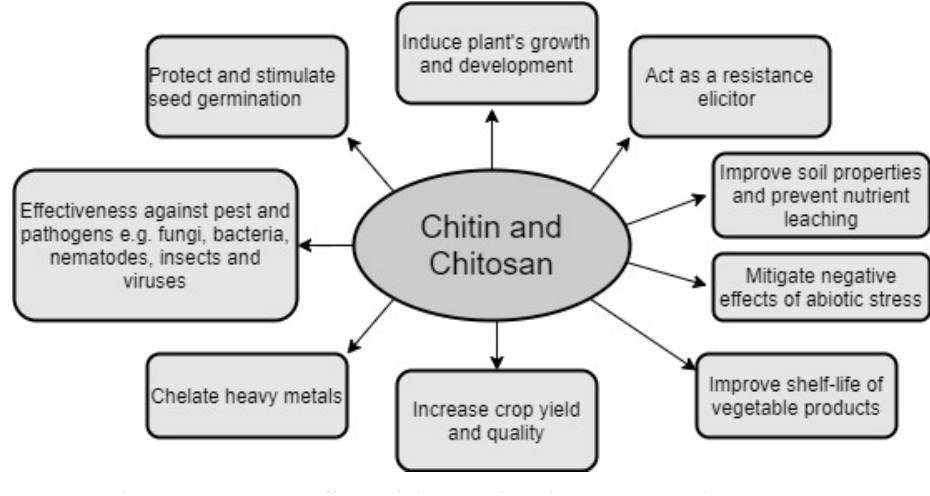
Figure 1. The most important effects of chitin and its derivatives’ applications.